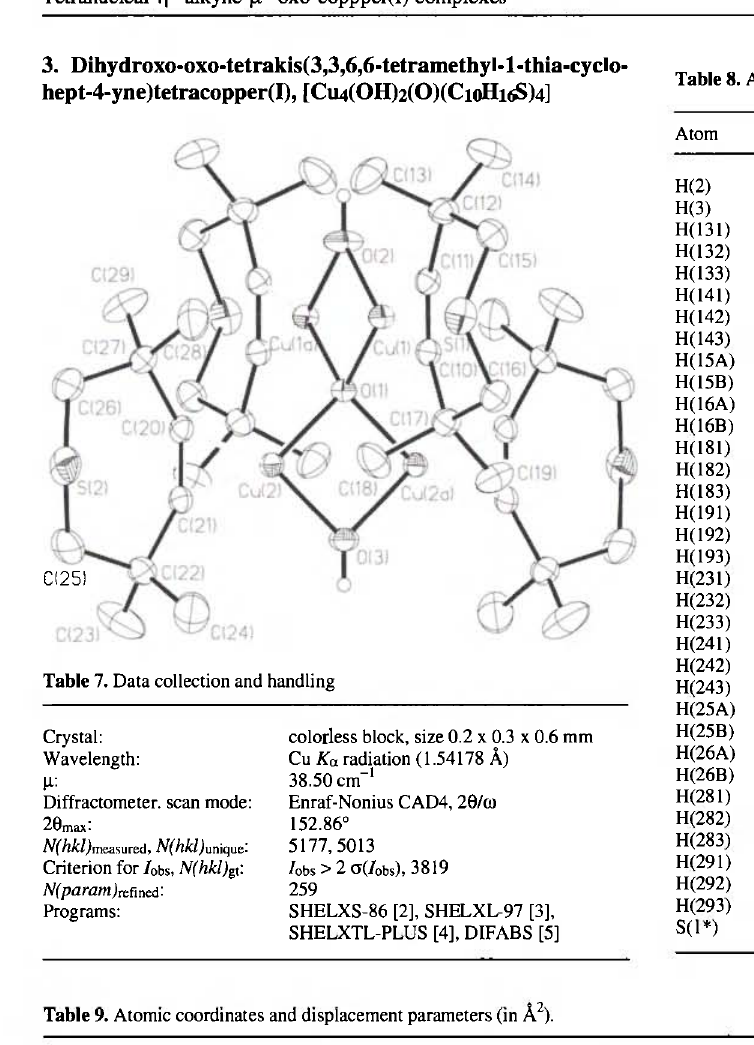
Table 9. Atomic coordinates and displacement parameters (in Ä 2 ).